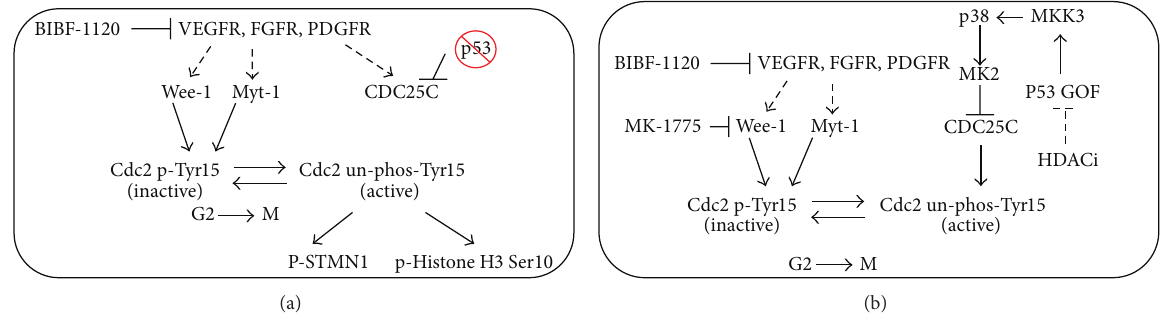
Figure 7: Proposed synergistic mechanisms for induction of mitotic cell death in endometrial cancer cells with mutant p53. (a) In the absence of functional p53, cells rely on the p38 pathway to maintain the G2/M checkpoint via inactivating phosphorylation of Cdc2 at Tyr15. Inhibition of RTK signaling with BIBF1120 results in premature entry into mitosis, where cells are sensitive to paclitaxel and thus undergo mitotic arrest and cell death. (b) In cells with p53 GOF mutation, the p38 pathway is hyperactivated through increased MKK3 transcription by p53 GOF. Synthetic lethality can be created by combining paclitaxel with BIBF1120 and an HDACi, which presumably disrupts the association of mutant p53 with Hsp90 and leads to its degradation. Alternatively, inhibition of Wee1, downstream of hyperactivated p38, is sufficient to restore sensitivity to